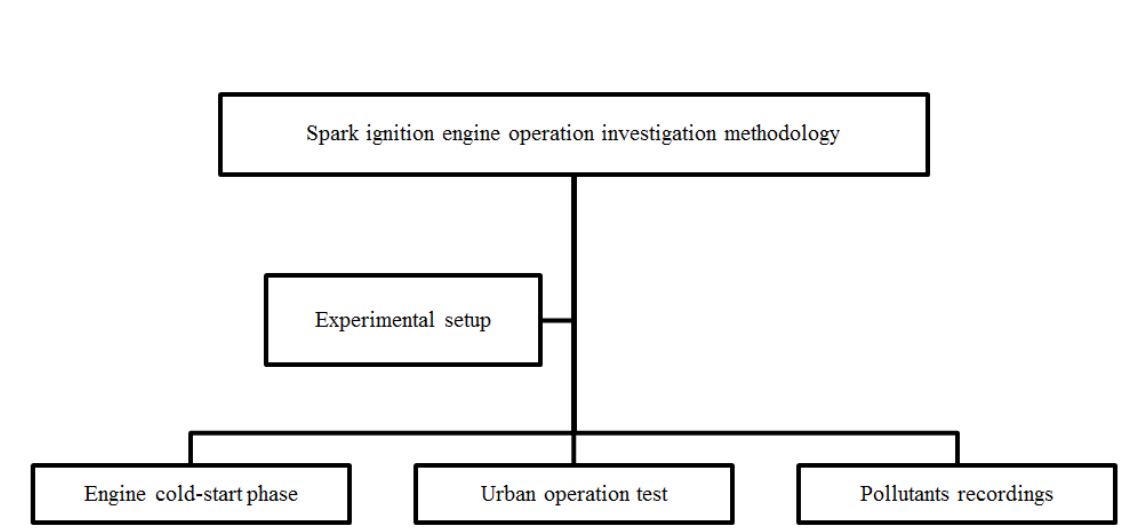
Figure 2. Experimental investigation protocol